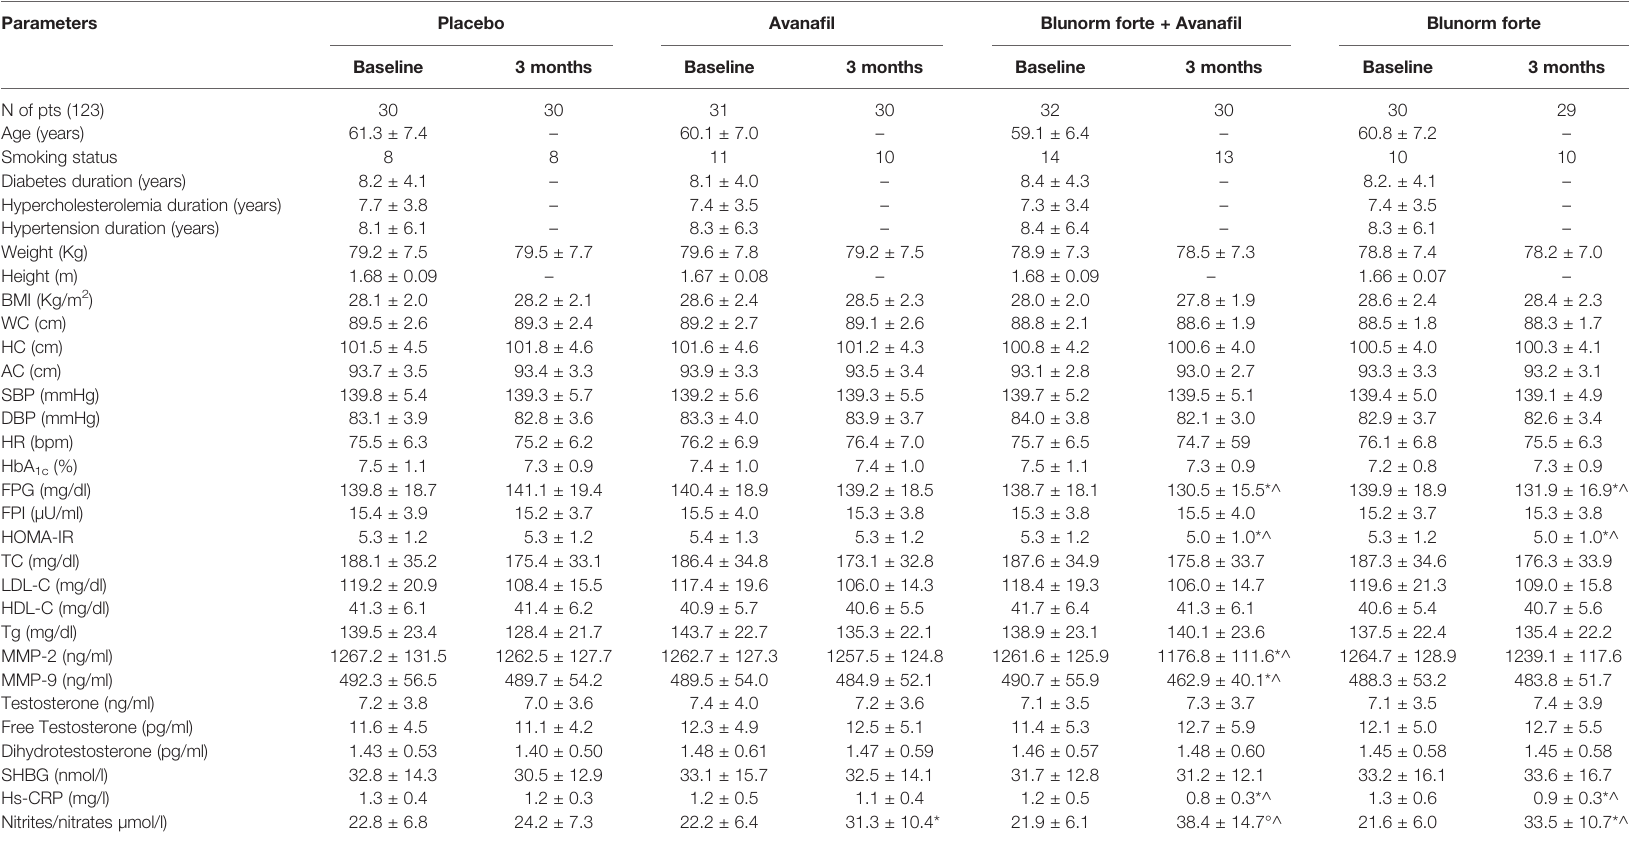
TABLE 3 | Baseline and 3 month results in the four groups of patients. Parameters